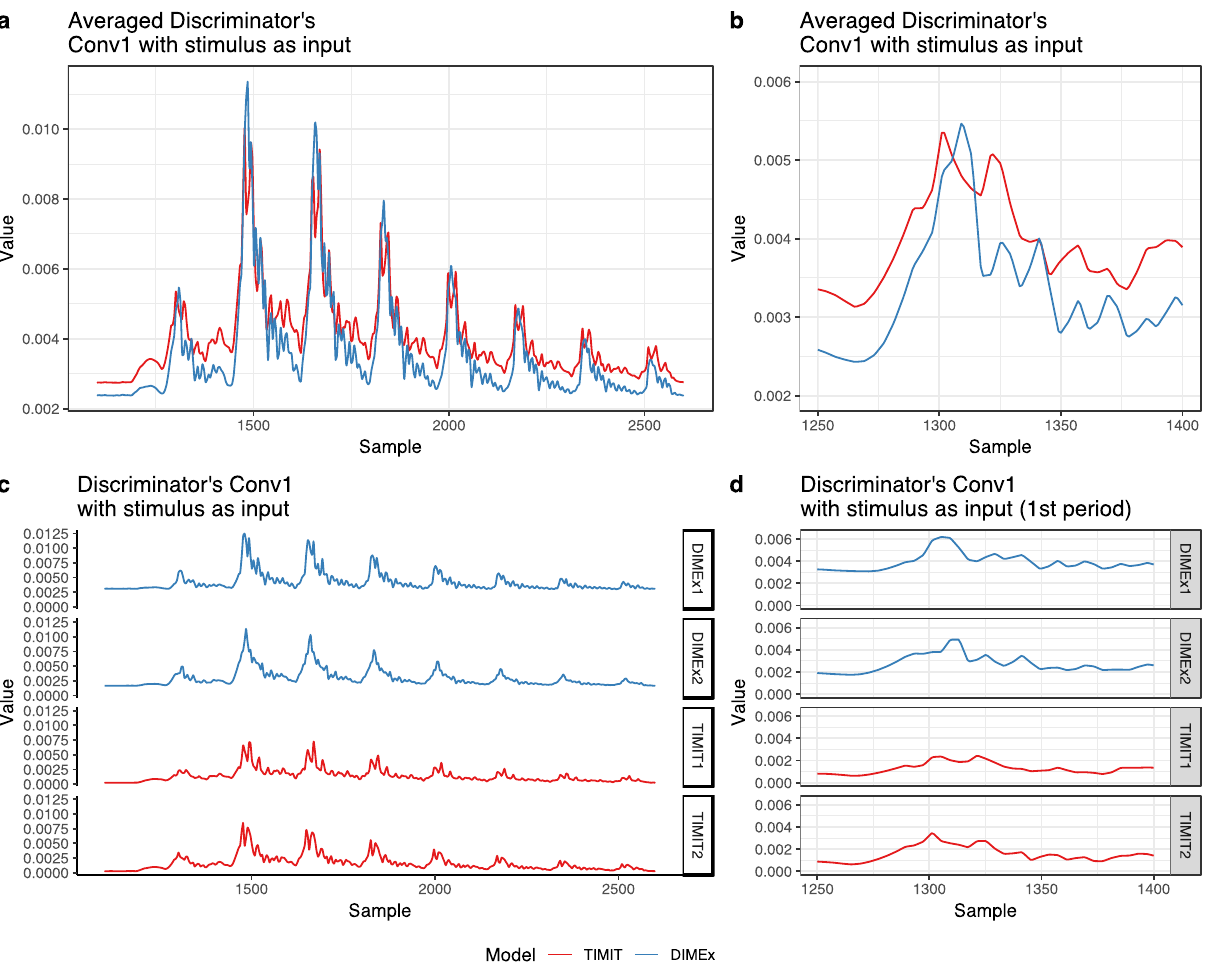
Figure 5. ( a ) Values of the first convolutional layer (Conv1) when the stimulus used in the brain experiment is the input to the Discriminator network. The figure shows averaged values across two replications of each model (DIMEx-trained or Spanish and TIMIT-trained or English). Values of the TIMIT outputs were increased by + 0.0025 on the y-axis to facilitate the comparison between signals. ( b ) Averaged values of the first convolutional layer (Conv1) when the stimulus used in the brain experiment is the input to the Discriminator network, zoomed in to the first period. Values of the TIMIT outputs were increased by + 0.0025 on the y-axis to facilitate the comparison between signals. ( c ) Individual values for each model (TIMIT1, TIMIT2, DIMEx1, DIMEx2) of the first convolutional layer (Conv1) when the stimulus used in the brain experiment is the input to the Discriminator network. ( d ) Individual values for each model (TIMIT1, TIMIT2, DIMEx1, DIMEx2) of the first convolutional layer (Conv1) when the stimulus used in the brain experiment is the input to the Discriminator network, zoomed in to the first